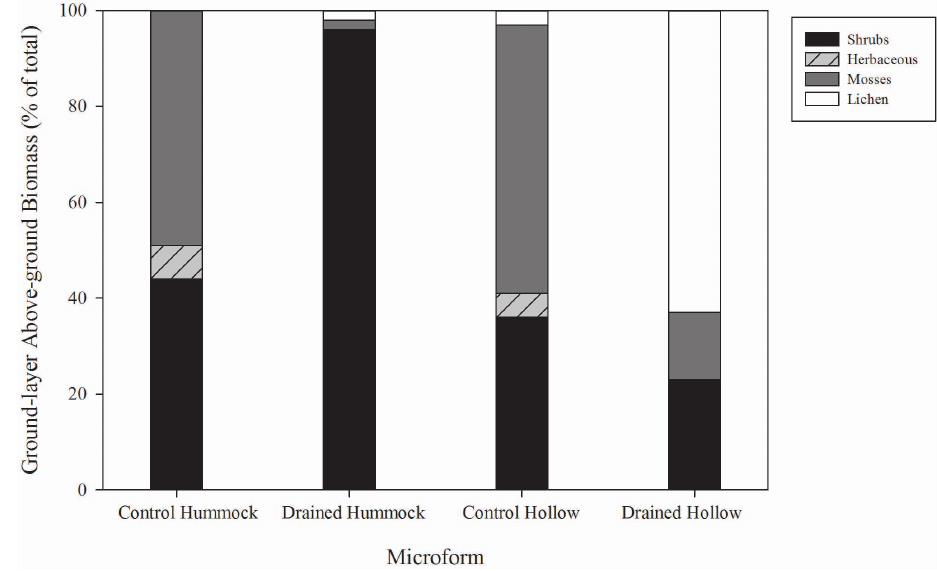
Fig. 3. Relationship between drainage/microform scenario and ground-layer aboveground biomass by category as a percentage of